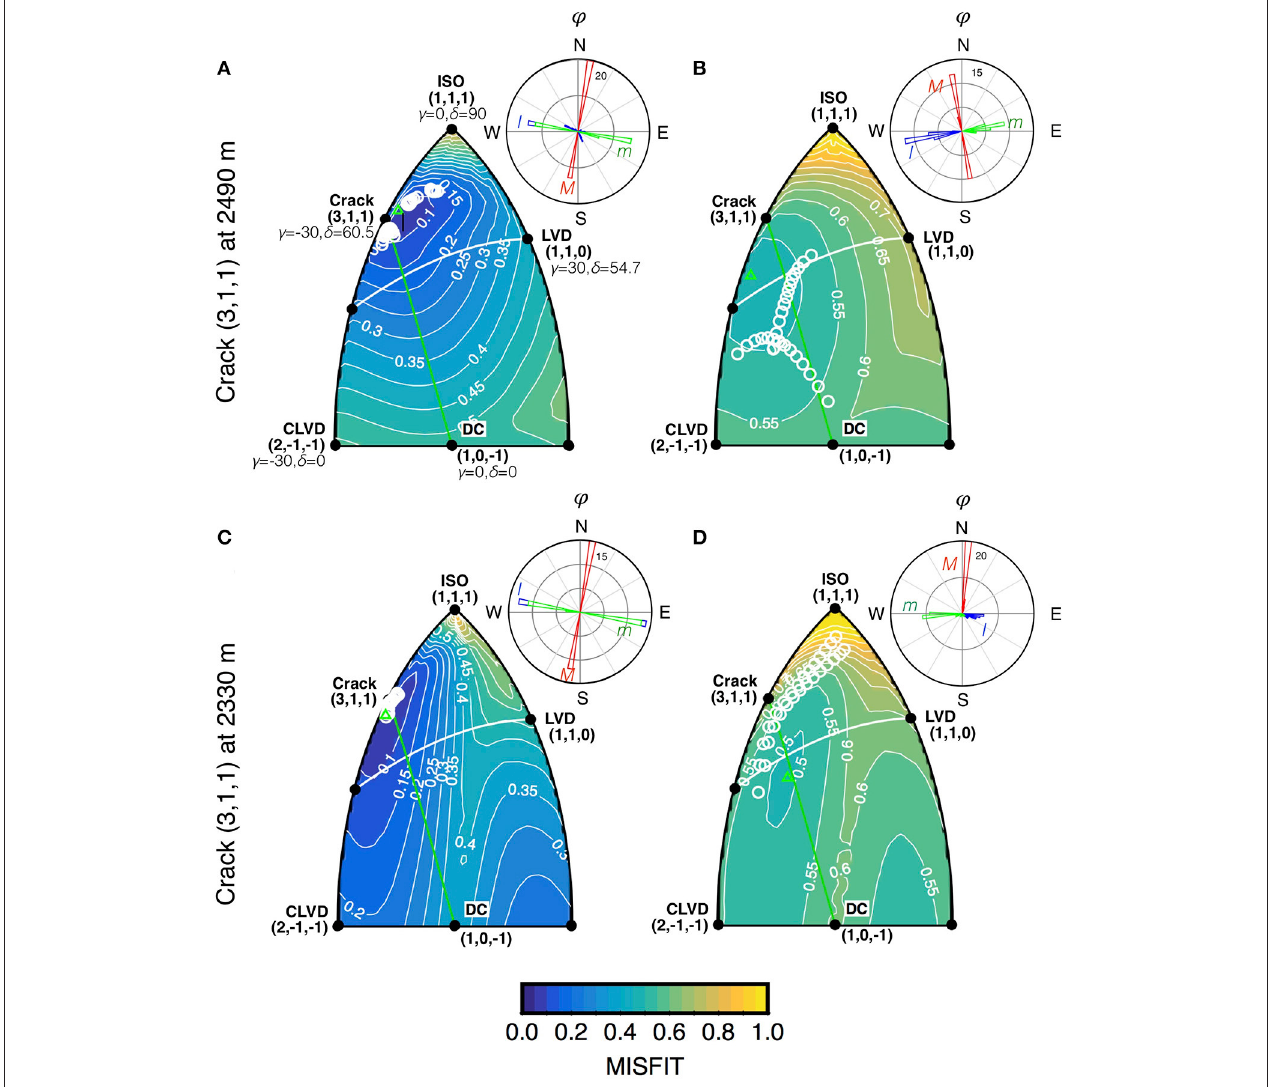
FIGURE 5 | Misfit by fixed moment tensor solution, plotted together with the point-by-point eigenvalue decomposition of the moment-tensor solution for the unconstrained inversion as white circles for a crack input source model located at 2490m, and 2330m a.s.l. The green triangles indicate the γ - δ pairs with the minimum misfit. (A) Solution for synthetic data generated with a homogeneous velocity model. (B) Solution for synthetic data generated with a 1D velocity model. (C) and (D) same as (A) and (B) but for an input source located at 2330m a.s.l. Rose diagrams show the orientations of the maximum, intermediate and minimum eigenvectors for the unconstrained inversion